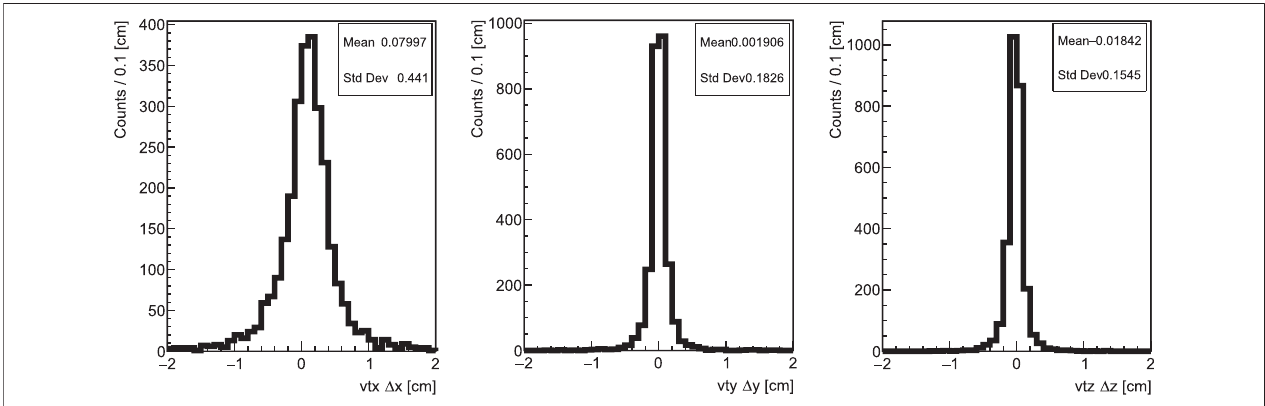
FIGURE 9 | Resolution on the reconstructed vertex position along the x (left) , y (middle) , and z (right) axes. The resolution has been computed for the tracks where an e + -e − leptons ’ pair has been correctly reconstructed and the leptons have been generated bya photon undergoing pair production within the converter plane.